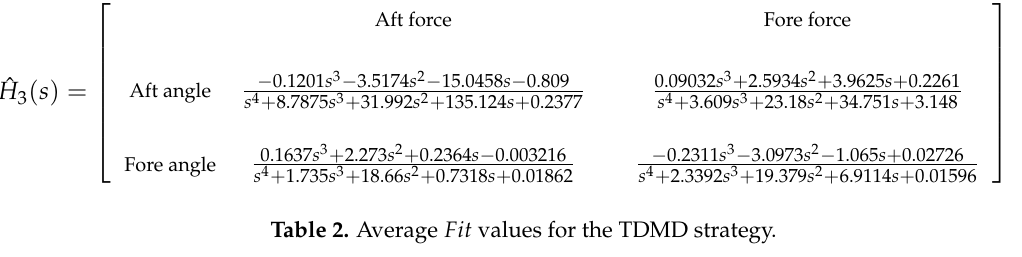
Table 2. Average Fit values for the TDMD strategy.